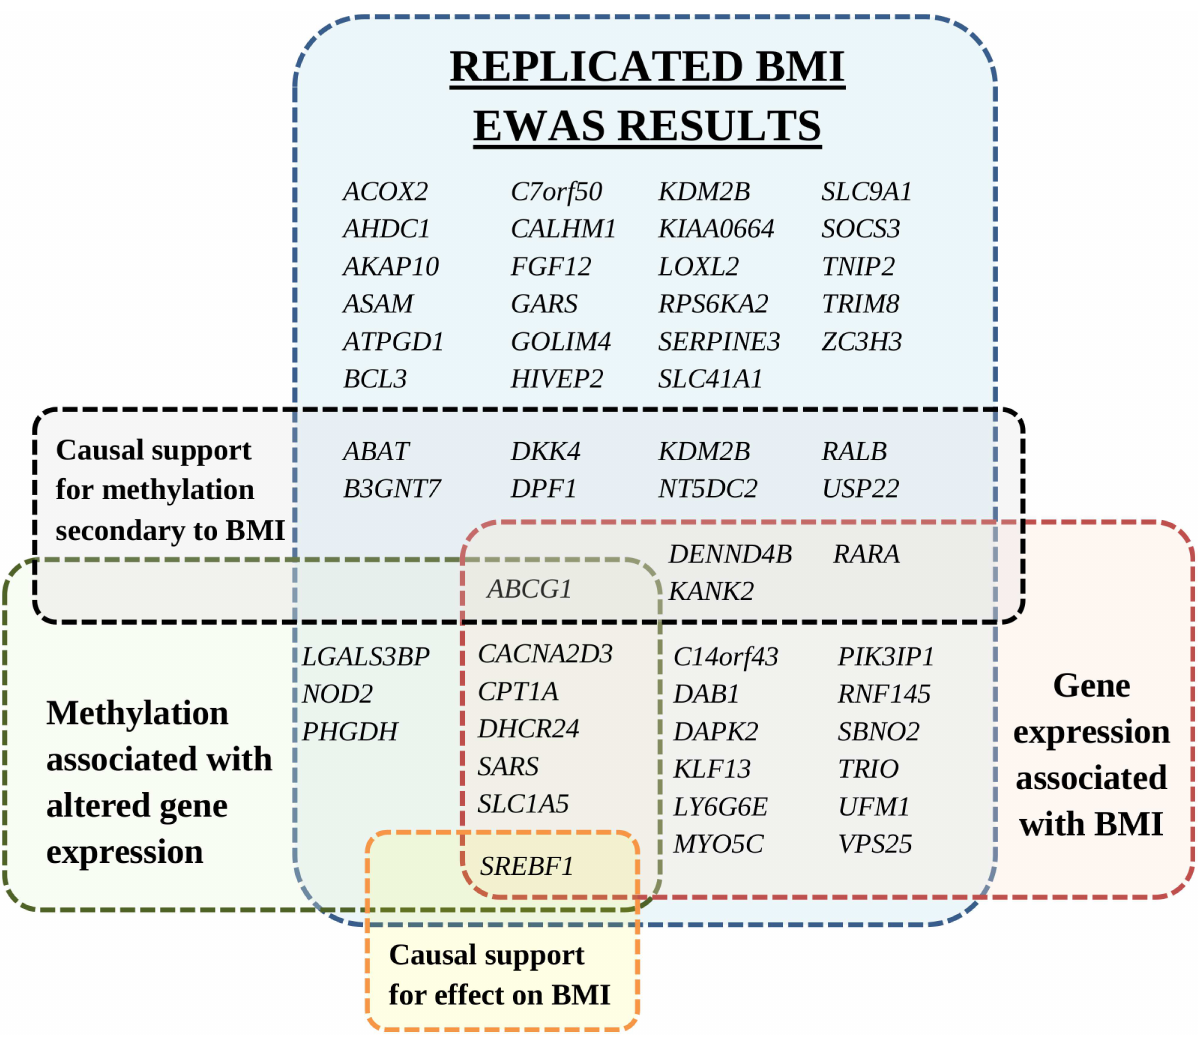
Fig 3. Annotated genes of replicated differentially methylated CpGs identified in the BMI epigenome-wide association study. Genes are groupedby associationwith gene expression, associationof geneexpressionwith BMI, and Mendelian randomization analyses for causal support. Duplicate gene names within the same group are not shown. Figure does not include18 intergenicCpGs without a gene annotation. BMI, body mass index; EWAS, epigenome-wide